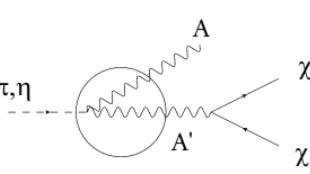
Figure 10. E(cid:11)ective (cid:12)eld theory approach to production of DP from rare meson decay.